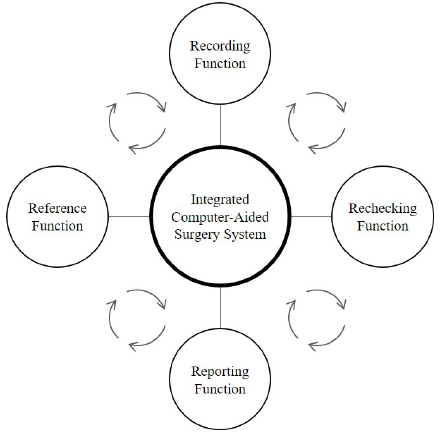
Figure 2. Integrated Computer-Aided Surgery